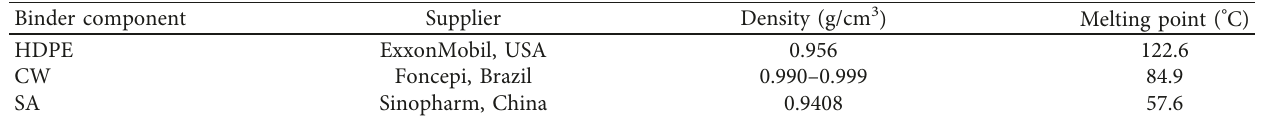
Figure 1: (a) Morphology of the AlSi alloy powder; (b) size distribution of the AlSi alloy powder. Table 1: Characteristics of binder components used in this